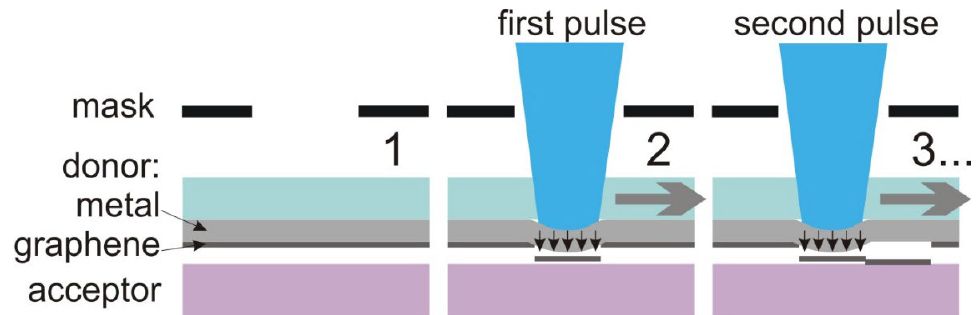
Figure 1. Sketch of the BB-LIFT technique used to print a graphene emitter. The large arrows indicate the shift of the donor and acceptor relative to the laser beam.